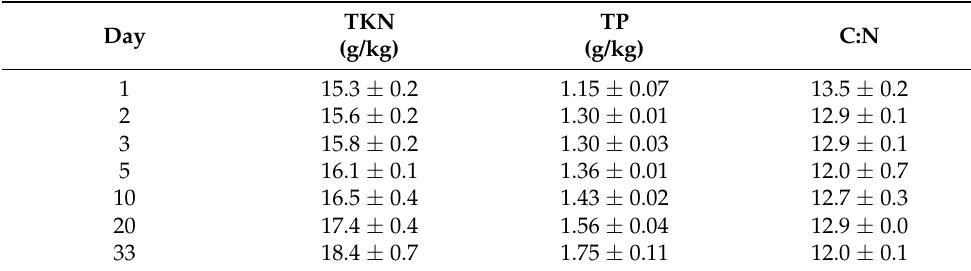
Table 2. Average and standard error of the total Kjeldahl nitrogen (TKN) and total phosphorus (TP) contents and the carbon-to-nitrogen (C:N) ratio of the compost over